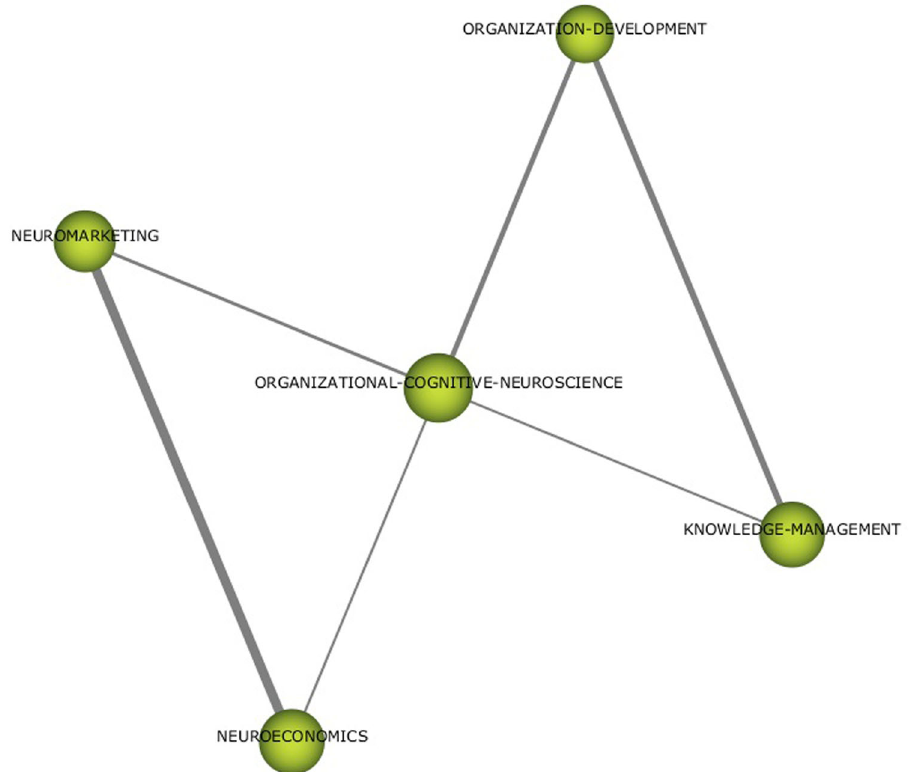
Fig. 7 Thematic networks for ORGANISATIONAL-COGNITIVE-NEUROSCIENCE (1992 – 2019). Results from SciMat, cluster network for organisational- cognitive-neuroscience (1992 –